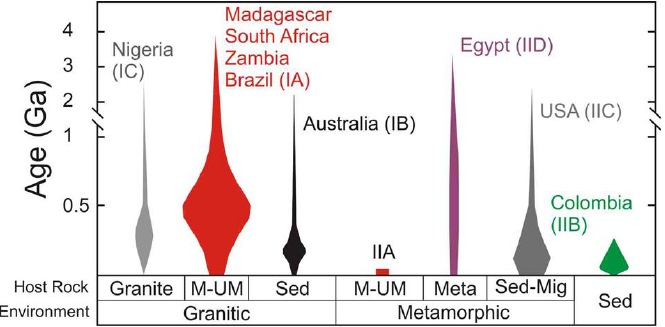
Figure 1. Summary of total age distribution of emerald host rock deposits classified by type. Type classifications (e.g., IC, IA, IB, IIA, IID, IIC and IIB) are based on host rock (abbreviations: M – UM = mafic – ultramafic; Sed = sedimentary; Meta = metamorphic; Sed – Mig = sedimentary – migmatite) and environment of formation [10] . Compilation of ages are in Tables 1 and S4; relative distribu- tion is shown (wider regions of indicator bars indicate a larger population of deposits of that age, and times can be discontinuous).